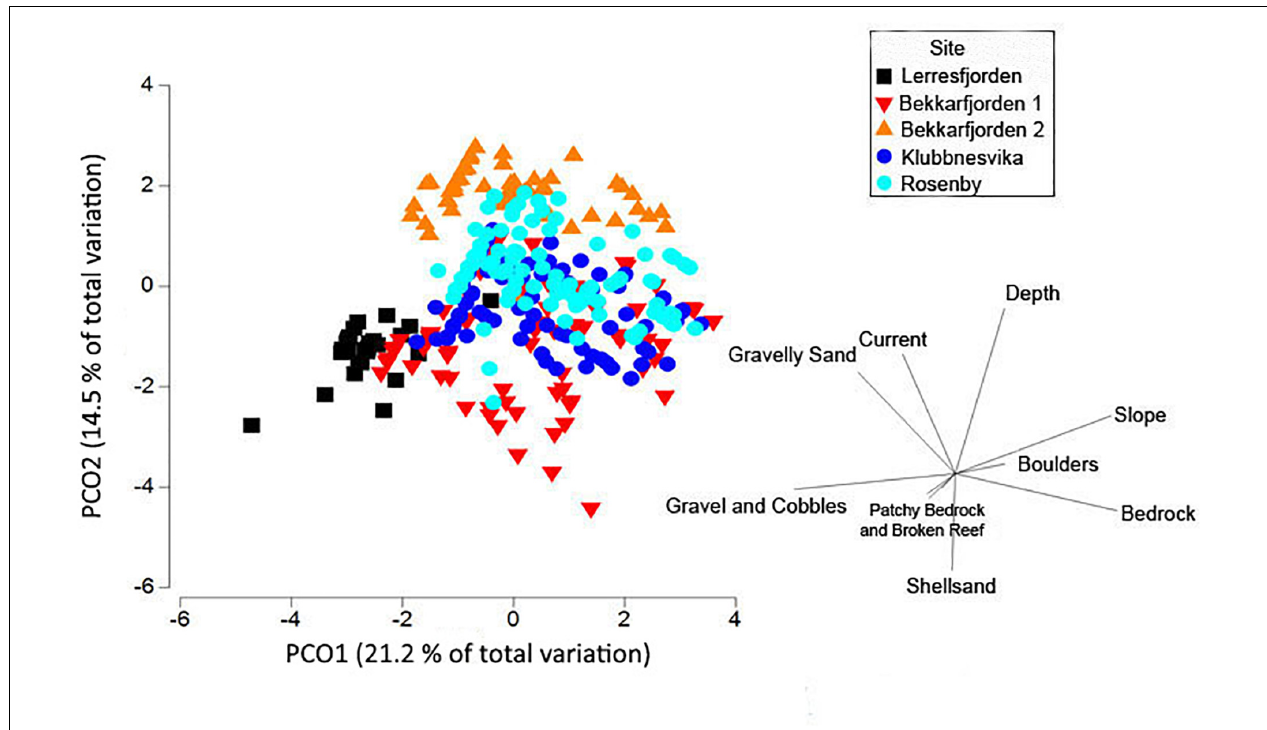
FIGURE 6 | Principal components analysis plot of the substrate type (gravelly sand, gravel and cobbles, sand, shellsand, bedrock, boulders, broken rocks and patchy bedrock and broken rocks) and other physical variables (slope, horizontal current velocity, and depth) at the five survey sites (Lerresfjorden, Bekkarfjorden 1 and 2, Rosenby, and Klubbnesvika). Environmental data was normalized and an Euclidean distance matrix applied.